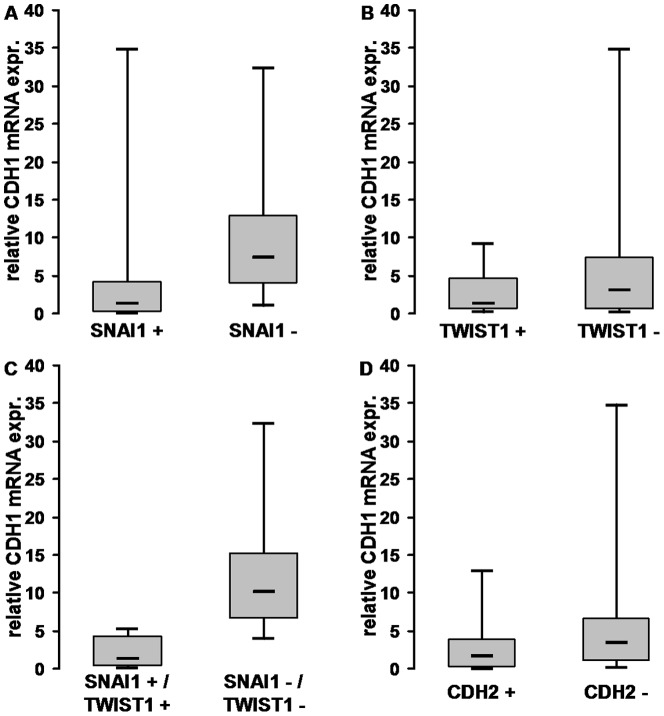
Expression of CDH1 mRNA in correlation to SNAI1, TWIST1 and CDH2 mRNA occurrence.See Methods for details on qRT-PCR and quantification. Y-axis: relative amount of CDH1 mRNA on a metric scale; X-axis: adenomas positive or negative for target transcript. Boxed regions enclose 25th to 75th percentiles, with the horizontal line indicating the median. Whiskers include 5th to 95th percentiles. A: The amount of CDH1 mRNA was significantly lower in SNAI1 positive adenomas compared to SNAI1 negative ones (p = 0.004). B: TWIST1 positive adenomas had a reduced amount of CDH1 mRNA, but the difference to TWIST1 negative adenomas did not reach significance (p = 0.29). C: Co-expression of SNAI1 and TWIST1 showed a highly significant reduction in CDH1 mRNA (p = 0.003). D: Adenomas with expression of CDH2 mRNA did not show any significant difference in the amount of CDH1 mRNA compared to adenomas without CDH2 mRNA (p = 0.24).